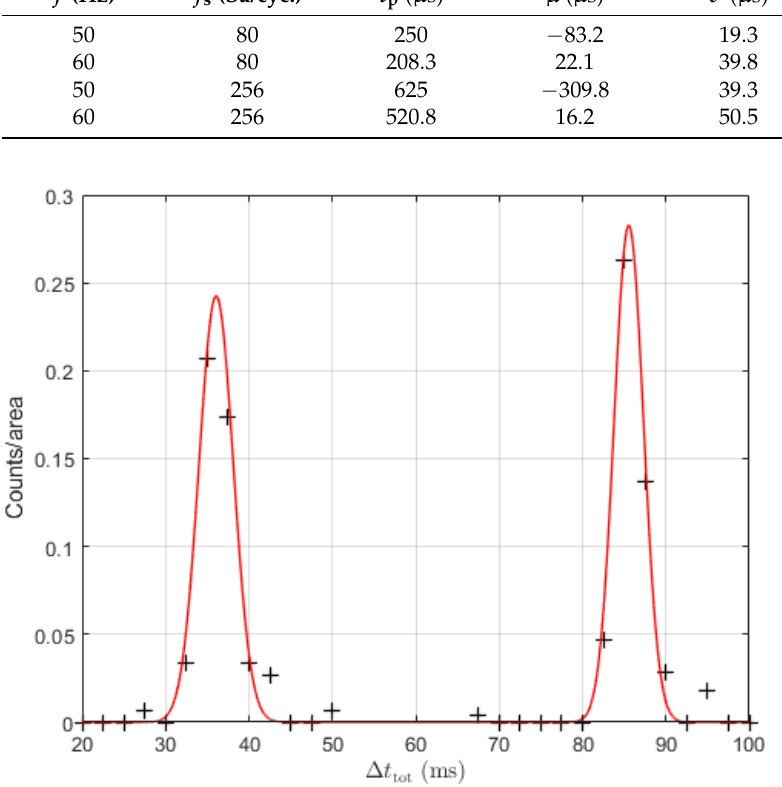
Figure 5. Probability distribution of the all transmitted packets within 1 s with respect to the PPS (crosses) measured according the STP method for the nominal transmission periods 250 µ s. The data are fitted with a Gaussian functions (red lines). The bin width is 2.5